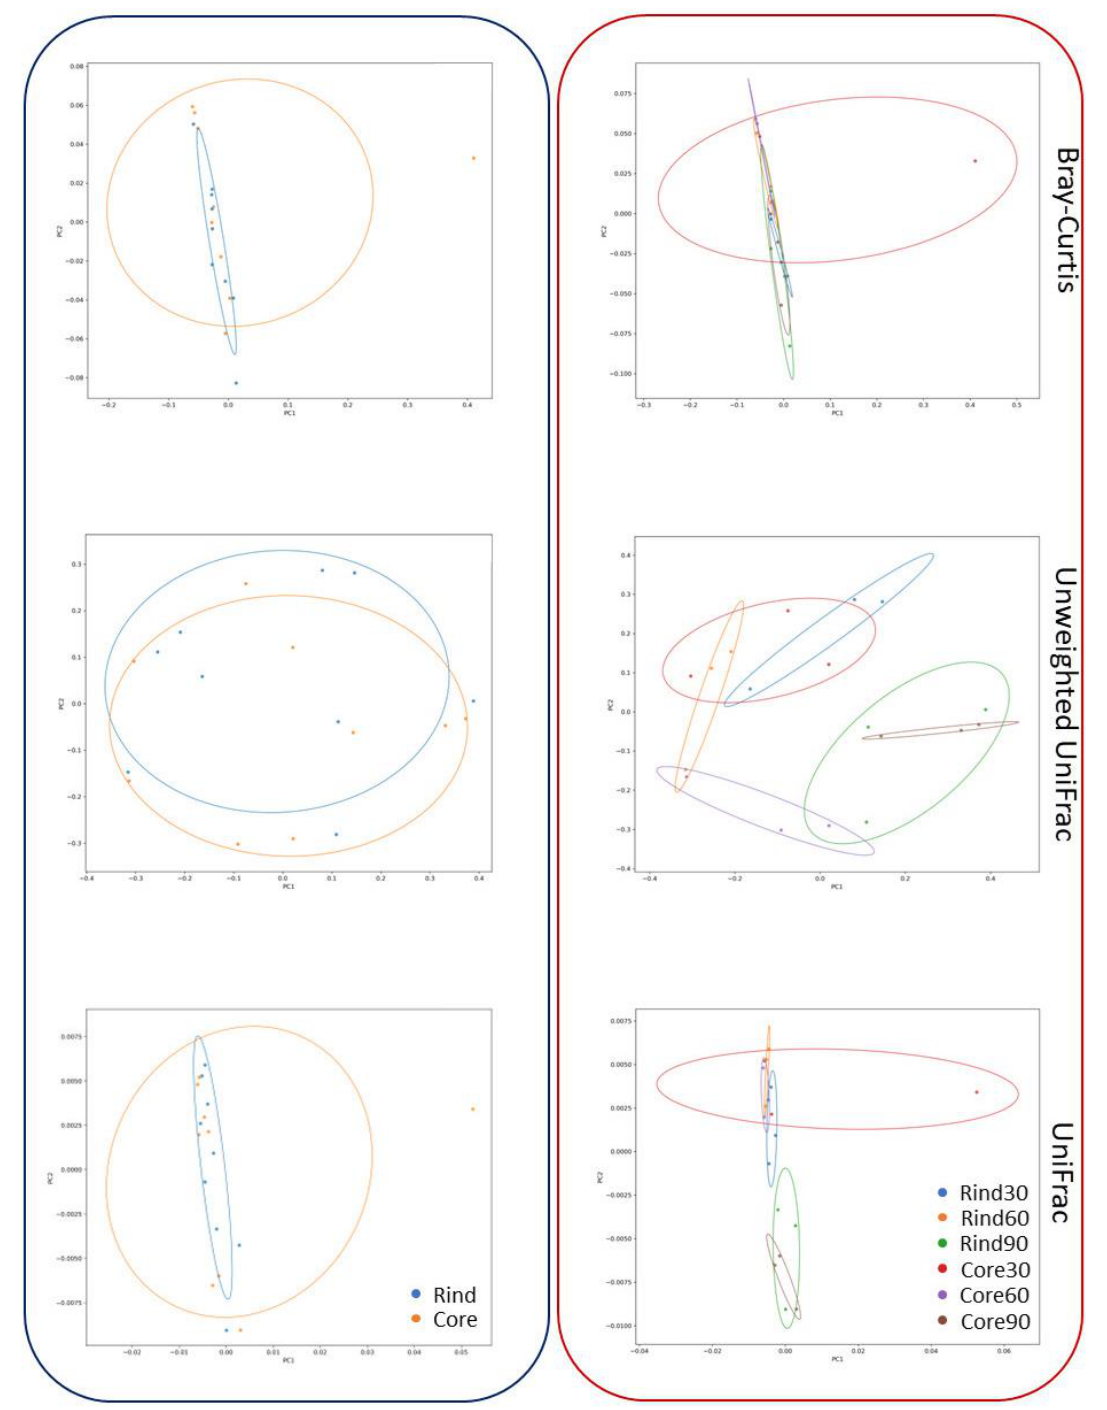
Figure 1. PCO plots of the 16S rRNA gene-sequencing data. The overall DNA-based dataset is visualized as PCO plots according to Bray–Curtis similarity, unweighted UniFrac, and UniFrac. Blue framed plots depict samples sorted according to the cheese-wheel depth (i.e., rind or core). Red-framed plots depict samples stratified according to both the cheese-wheel depth and ripening